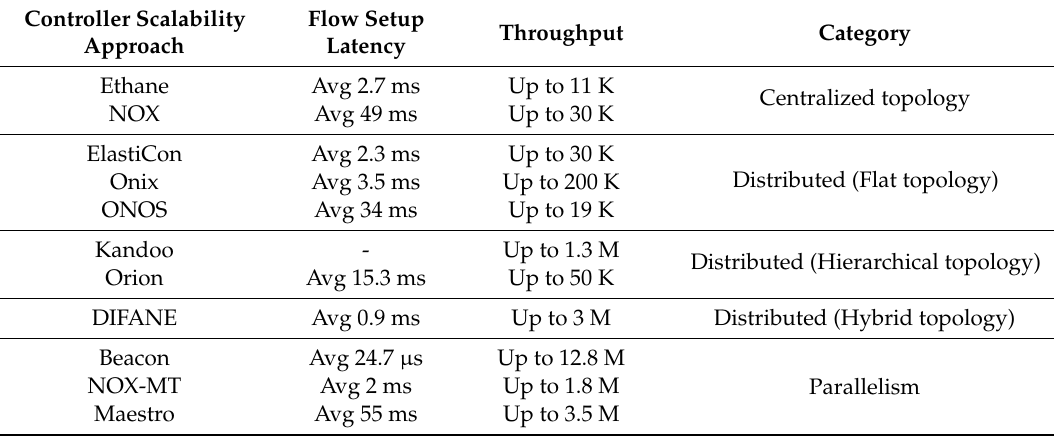
Table 2. Performance Comparison of the Control Plane Scalability